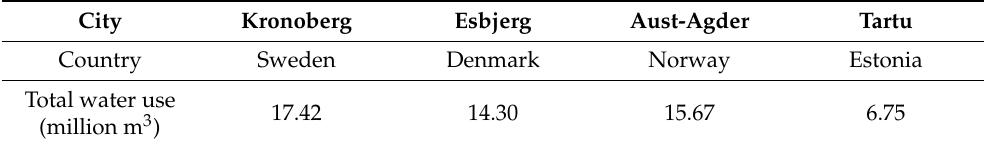
Table 3. Total water use of some European cities in